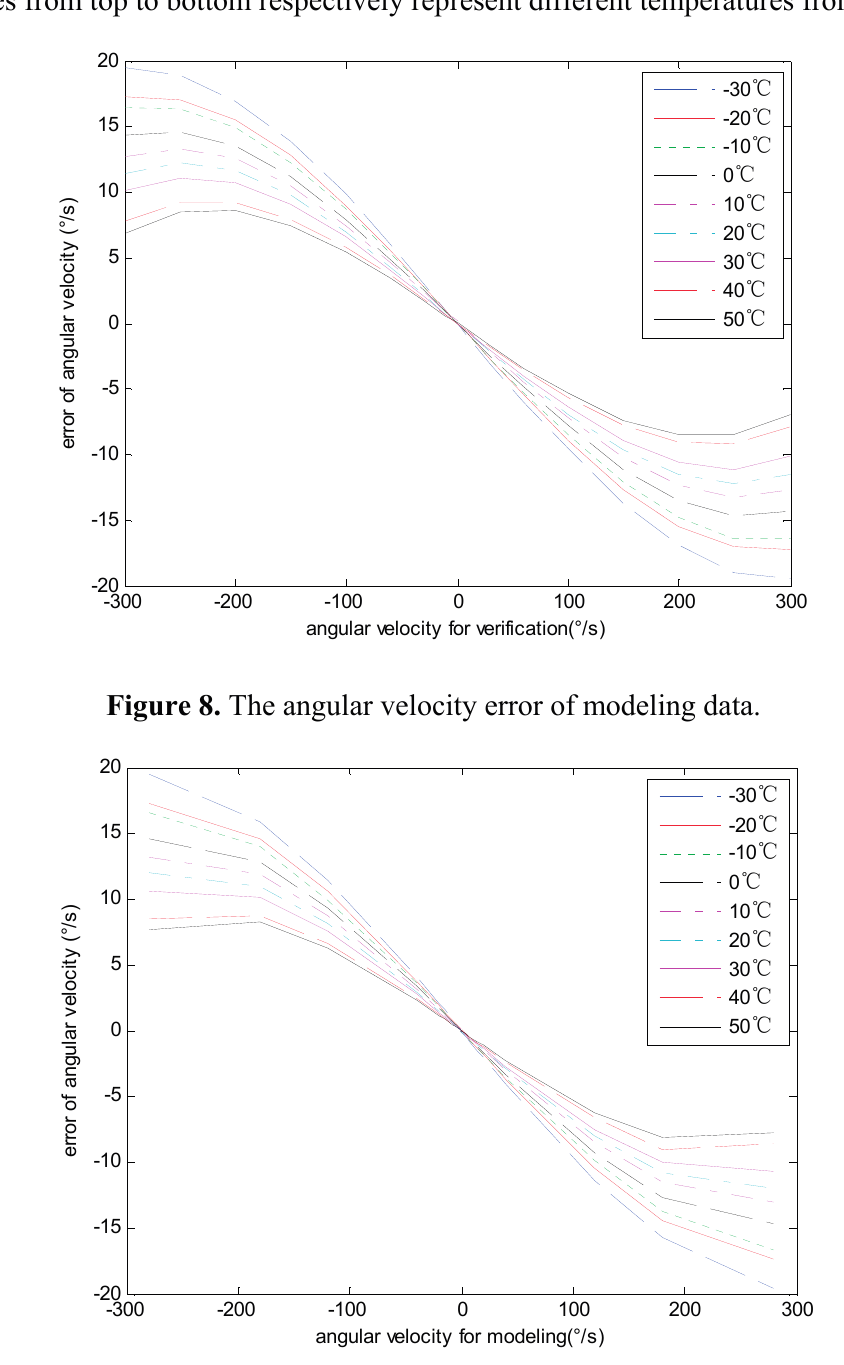
Figure 9. The angular velocity error of model verification